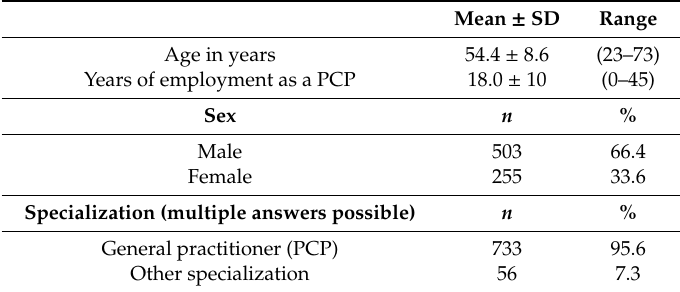
Table 1. Socio-demographic variables of the surveyed primary care physicians ( n = 758, PCPs with missing surveys =